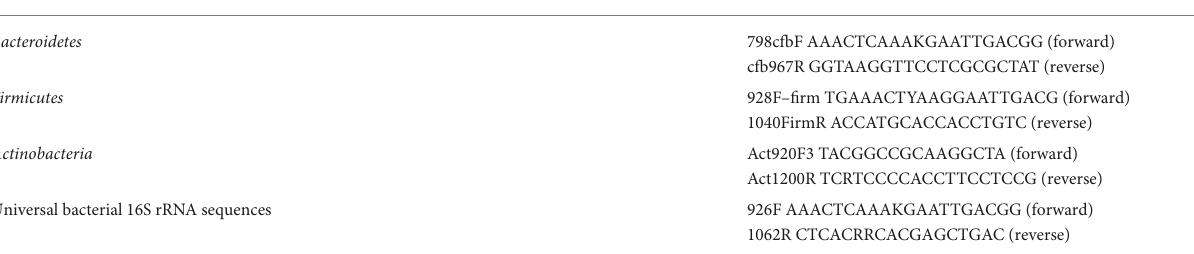
TABLE 1 Primers used for